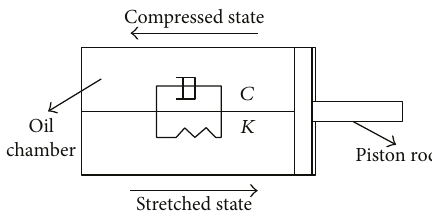
Figure 2: A schematic diagram of sti ff ness calculating a hydraulic cylinder.